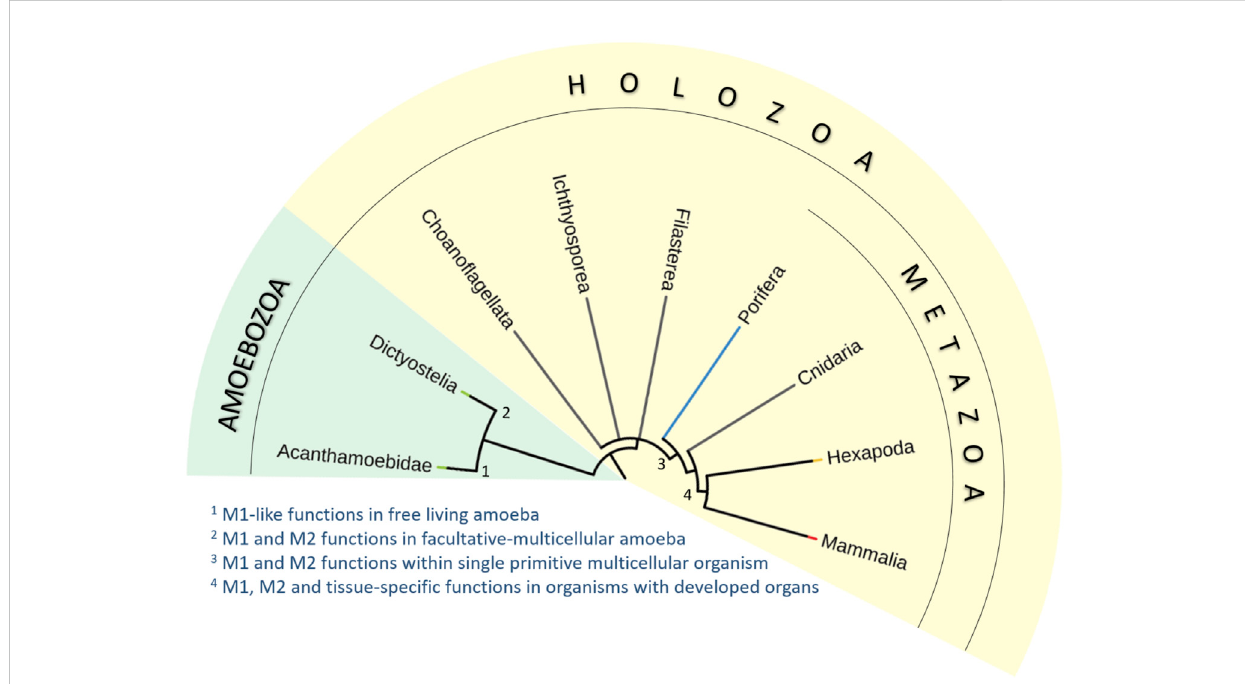
FIGURE 2 Simpli fi edphylogenictreeof Holozoa andtheirrelatives.Wehaveanalyzedtheoccurrenceofcharacteristicfeaturesofmammalianmacrophagesin unicellular free-living amoeba ( Acanthamoeba ; 1 ), social facultative-multicellular amoeba ( Dictyostelium ; 2 ), macrophage-like amoebocytes in primitive multicellular animal lacking true tissues and organs ( Porifera ; 3 ), and macrophage-like plasmatocytes of simple multicellular organisms with fully developedorgansandtissues( Drosophila ; 4 ).Weproposethatmanymacrophagecharacteristicsareinheritedfromunicellularancestorsofanimals. The functional repertoire of macrophages then diversi fi ed with the emergence of multicellularity and increasing complexity of body plan and development of organ